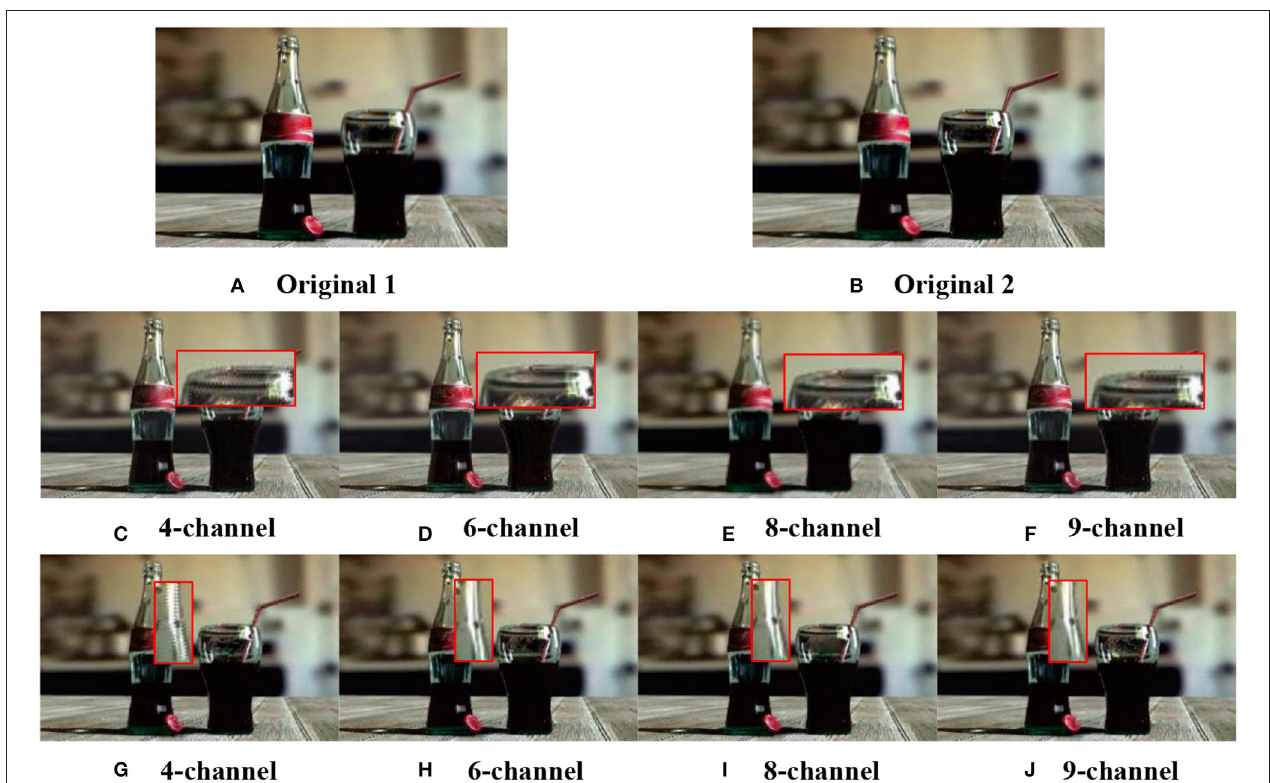
FIGURE 3 | Tested multi-focus color image. (A,B) are original images. The parameters are selected: in (C–F) , layer P 3, t 0.9, T 0.03; with four, six, eight, and nine decomposition channels. = = =